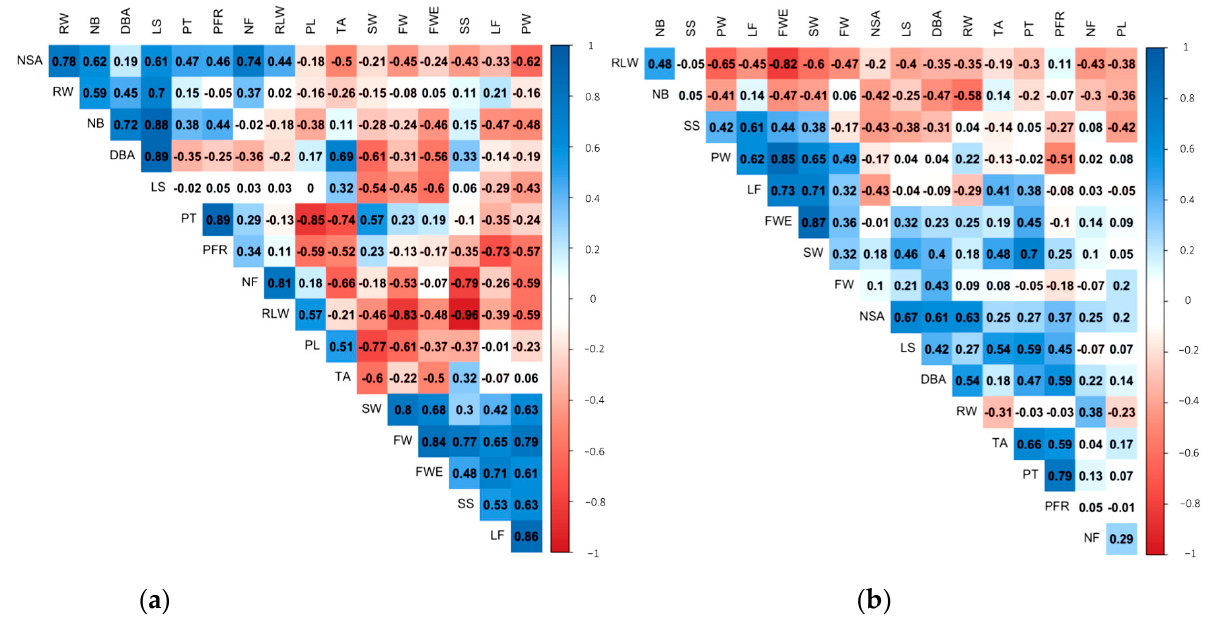
Figure 2. Pearson correlations between quantitative variables of yellow pitahaya genotypes: ( a ) open field and ( b ) under cover. Number of fruits (NF), length of the phylloclade (LF), distance between areolas (DBA), number of spines per areola (NSA), width of the ribs (RW), length of the largest spine (LS), length of the fruit (LF), fruit width (FW), length/width ratio (RLW), fruit weight (FWE), peel weight (SW), pulp weight (PW), pericarp thickness (PT), peel/pulp ratio (PFR), number of bracts (NB), soluble solids (SS), and titratable acidity (TA).